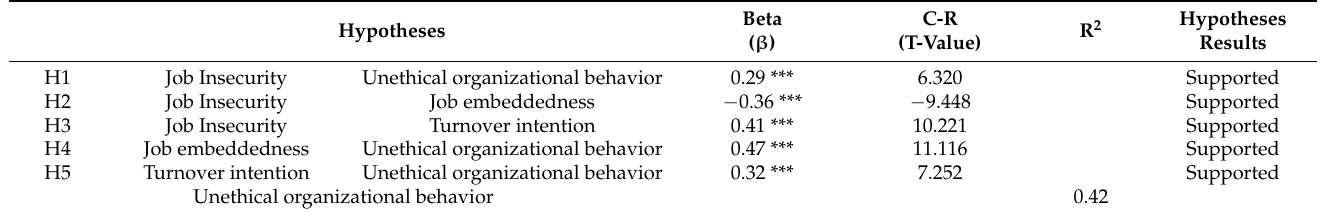
Table 4. Result of the structural model (developed by